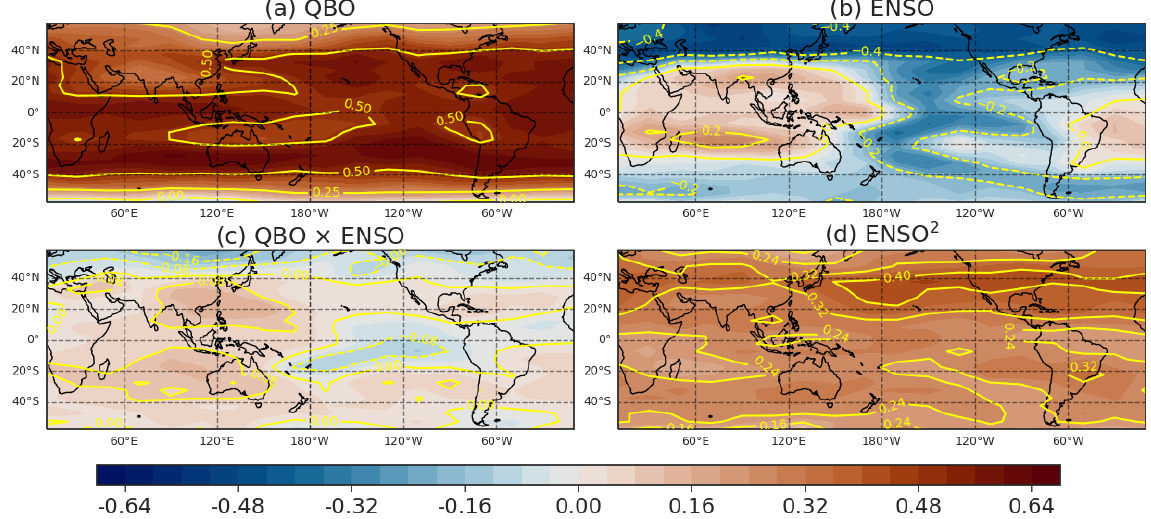
Figure 6. The in-sample β coefficients for the MLR analysis of water vapor at the 82.54hPa level from 2005 to 2019, performed using the 3D SWOOSH data.